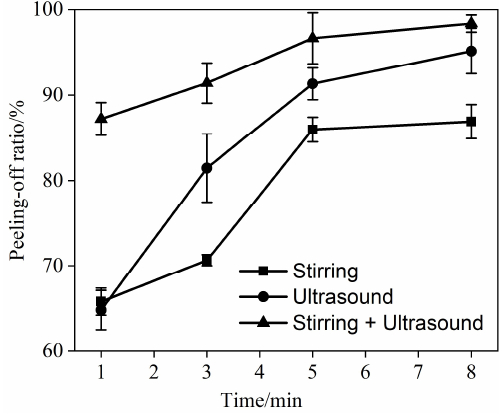
Figure 8. Effect of treatment time on peeling-off ratio of ultrasound-mechanical stirrer.